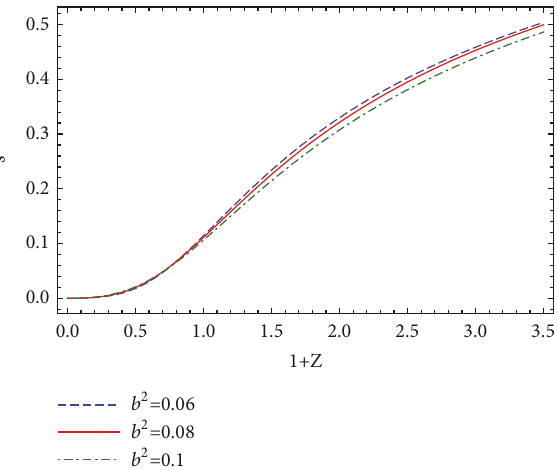
Figure 13: The evolution of the squared of sound speed V 2 𝑠 versus redshift parameter 𝑧 for interacting GDE in the DGP model. Here, we have taken Ω 𝐷 (𝑧 = 0) = 0.73 , 𝐻(𝑧 = 0) = 67 , and Ω 𝑟